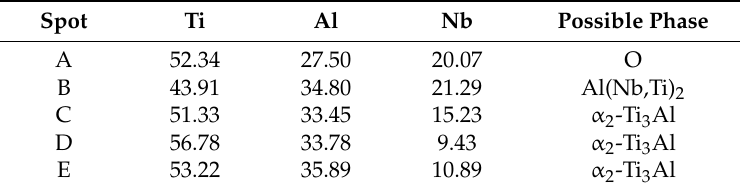
Figure 5. BSE images of interfacial microstructure of bonded joints at 970 °C /5 MPa for ( a ) 60 min, ( b ) 90 min, ( c ) 120 min, ( d ) 150 min. Table 2. Chemical compositions and possible phases of each spot marked in Figure 5c (atom %).